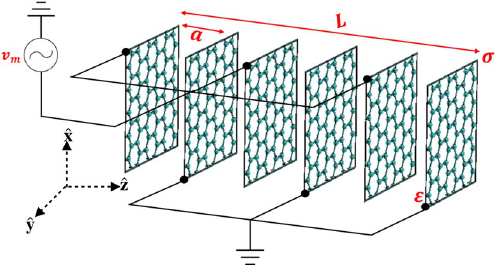
Figure 1. Schematic representation of the electrically driven graphene multilayer